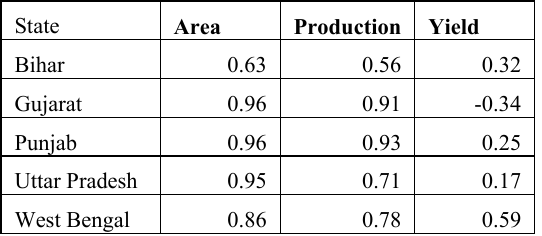
Table 4. Correlation coefficient of Trend Analysis of 6 years’